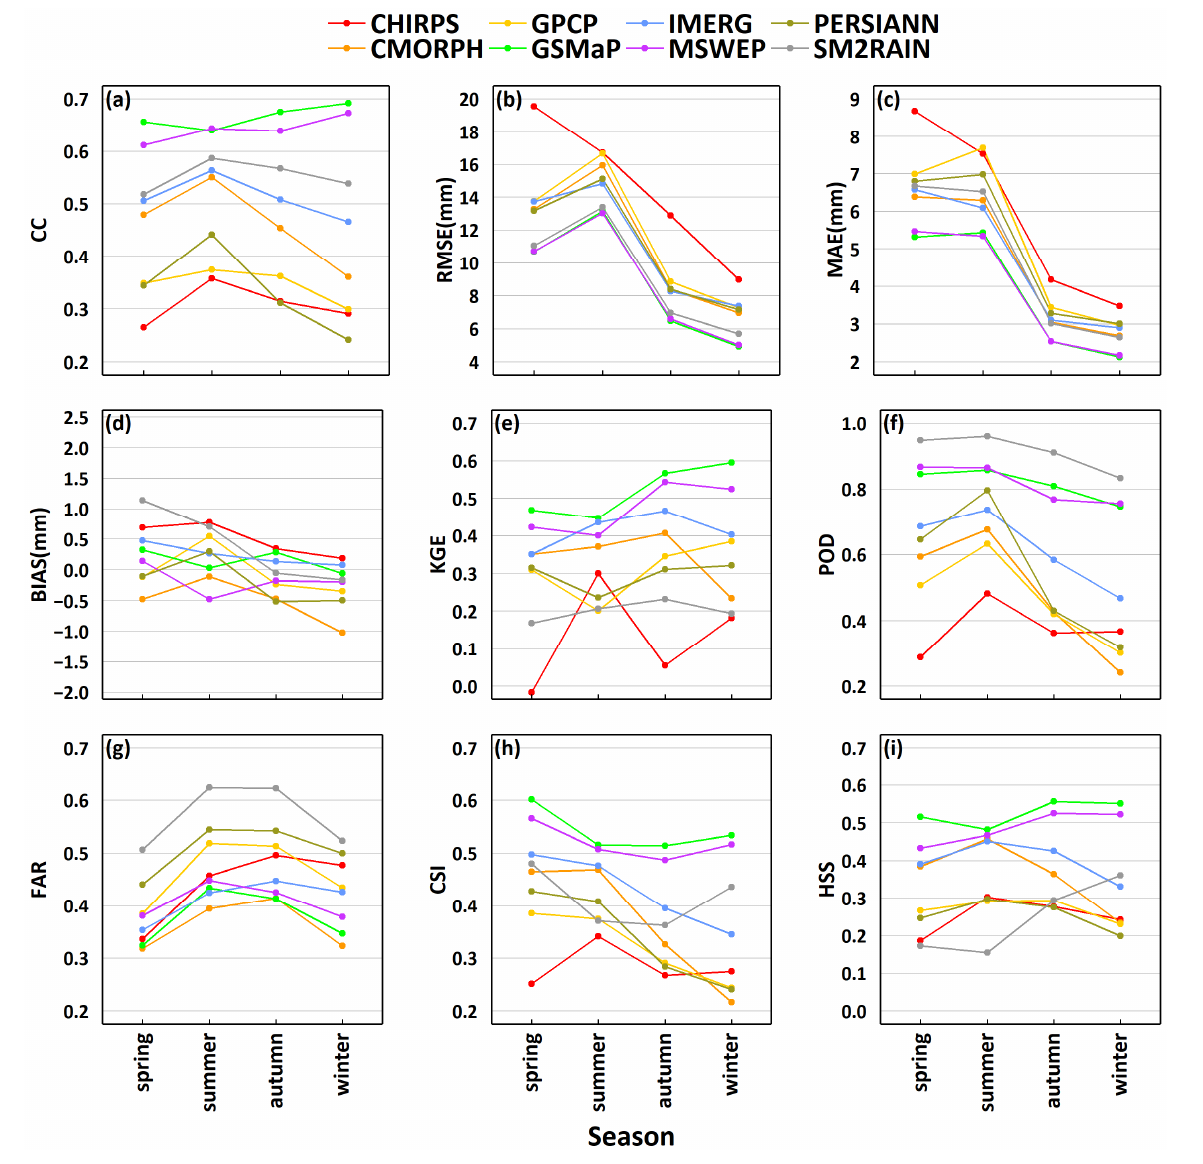
Figure 4. Seasonal (from 2007 to 2020) ( a ) CC, ( b ) RMSE, ( c ) MAE, ( d ) BIAS, ( e ) KGE, ( f ) POD, ( g ) FAR, ( h ) CSI, and ( i ) HSS at grid scale for the eight SPPs in XJRB. Different coloured dots and lines represent each precipitation product. Table 4. Seasonal (from 2007 to 2020) R-BIAS (BIAS) at the watershed scale for the eight SSPs compared with the seasonal accumulation of rain-gauged observations